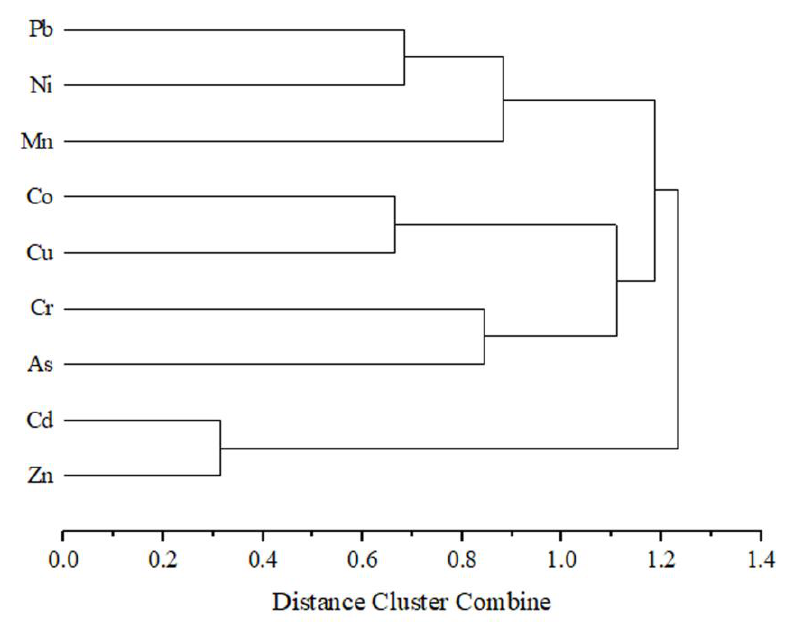
Figure 6. Dendrogram results of cluster analysis for PTEs in the study area.